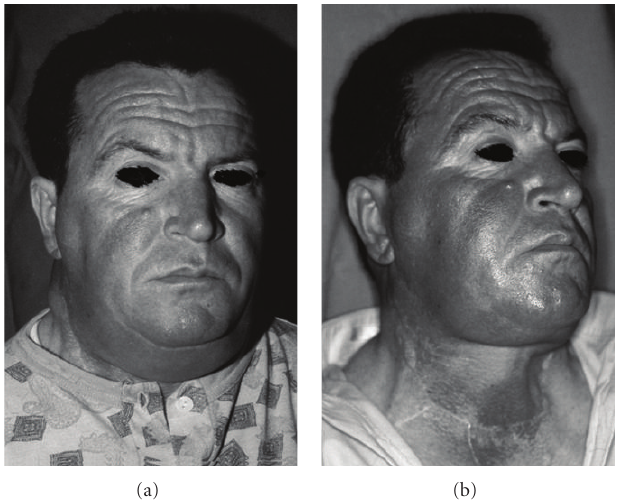
Figure 2: Preoperative view (a), and postoperative view (b) of second patient. The image sequence shows bu ff alo hump and horse collar